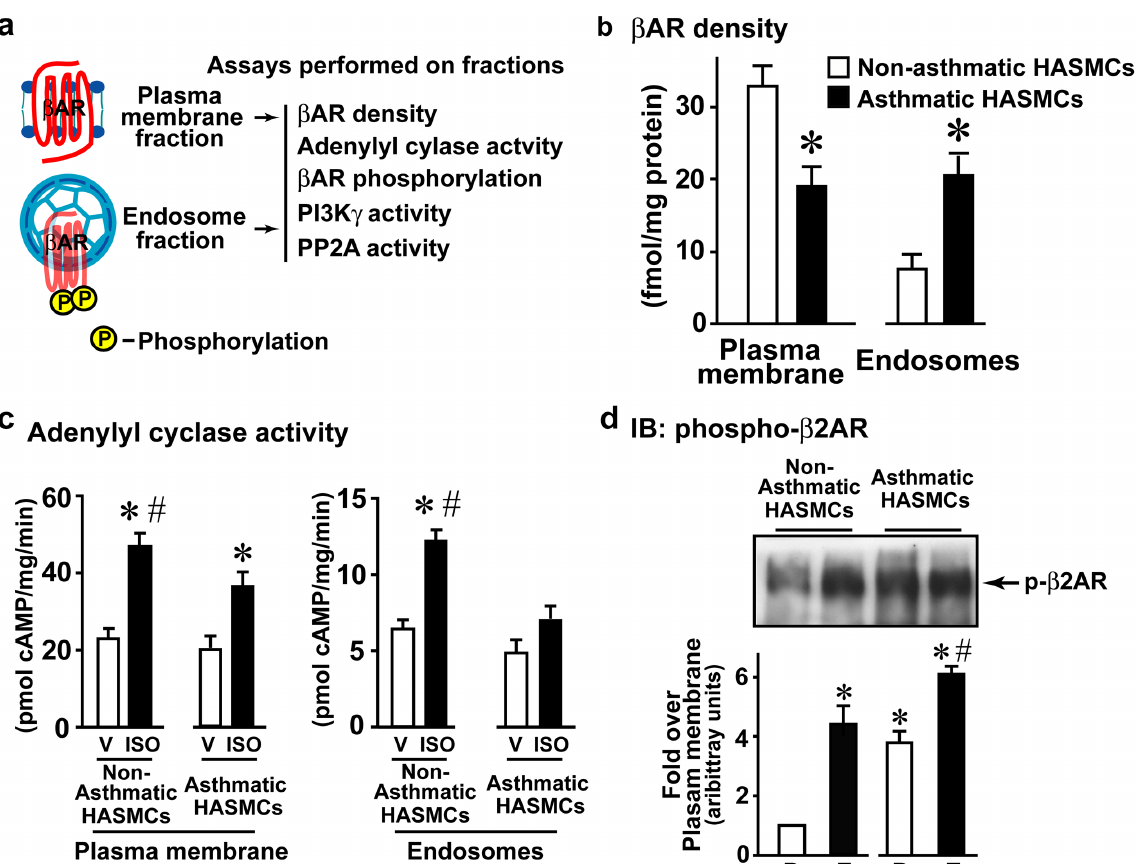
Fig 4. Measure of β AR resensitization in non-asthmatic ASM and asthmatic ASM cells ( β AR function, density and distribution). a , To obtain a measure of resensitization that mediates β AR dephosphorylation leading to generation of agonist ready receptors in the endosomes, endosomes were isolated from non-asthmatic ASM and asthmatic ASM cells, and subjected to various assays. b , Plasma membranes and endosomes isolated from non- asthmatic ASM and asthmatic ASM cells were subjected to [125] I-CYP (cyanopindalol) β AR binding at saturation concentration of 250 pmol. * p < 0.005 vs. Non-ASM, (n = 4/group). c , Plasma membranes and endosomes isolated from non-asthmatic ASM and asthmatic ASM cells were subjected to cell-free membrane associated β -agonist (isoproterenol, ISO)-stimulated adenylyl cyclase activity. * p < 0.01 vs. respective cell-free vehicle (V) stimulation, #p <